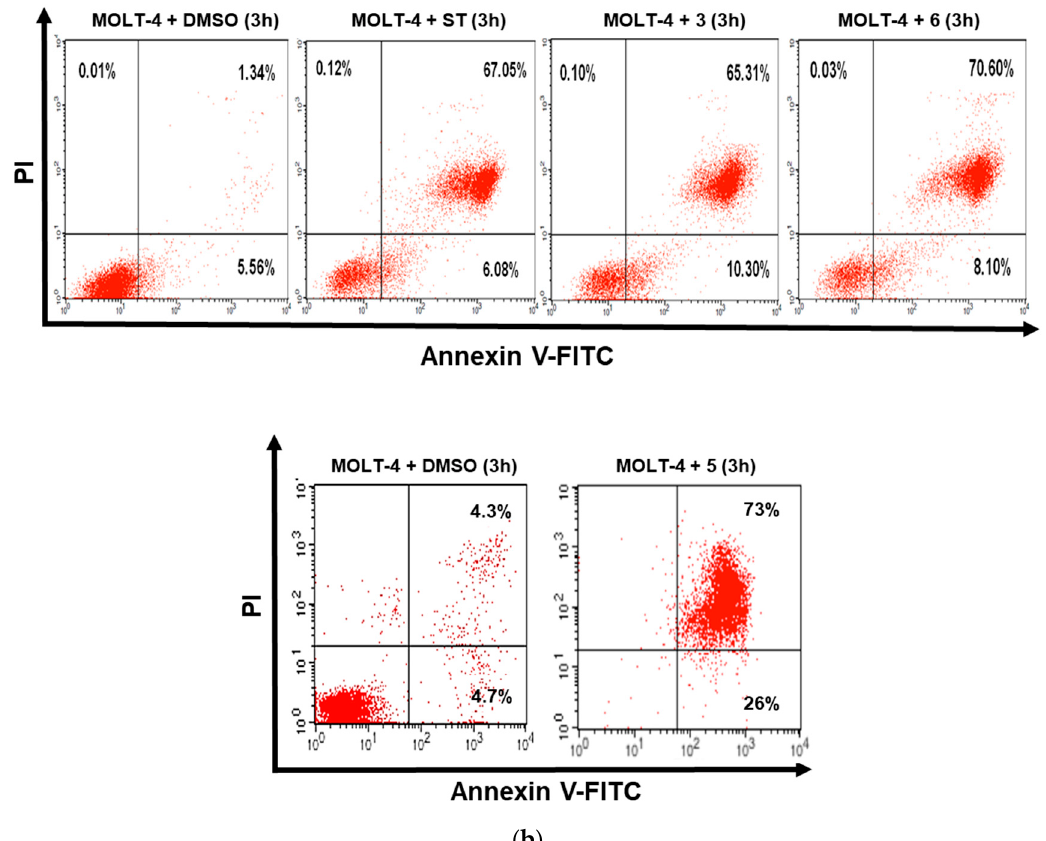
Figure 2. Flow cytometry analysis of apoptosis in leukemia cells induced by the test compounds or staurosporine. Apoptosis was determined by Annexin V Fluoroscein Isothiocyanate (FITC) Apoptosis Detection Kit I, (BD Pharmingen). The test compound and time of incubation with cells is given above each scatterplot. ( a ) scatterplots of K562 cells stained with Annexin V FITC and PI